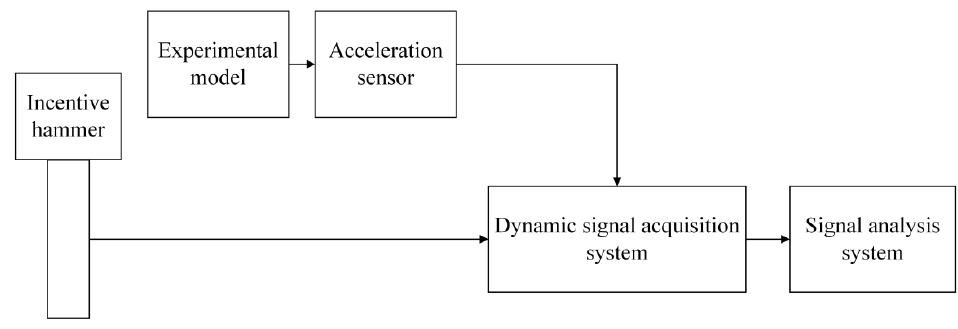
Figure 3. Flowchart of modal test analysis.